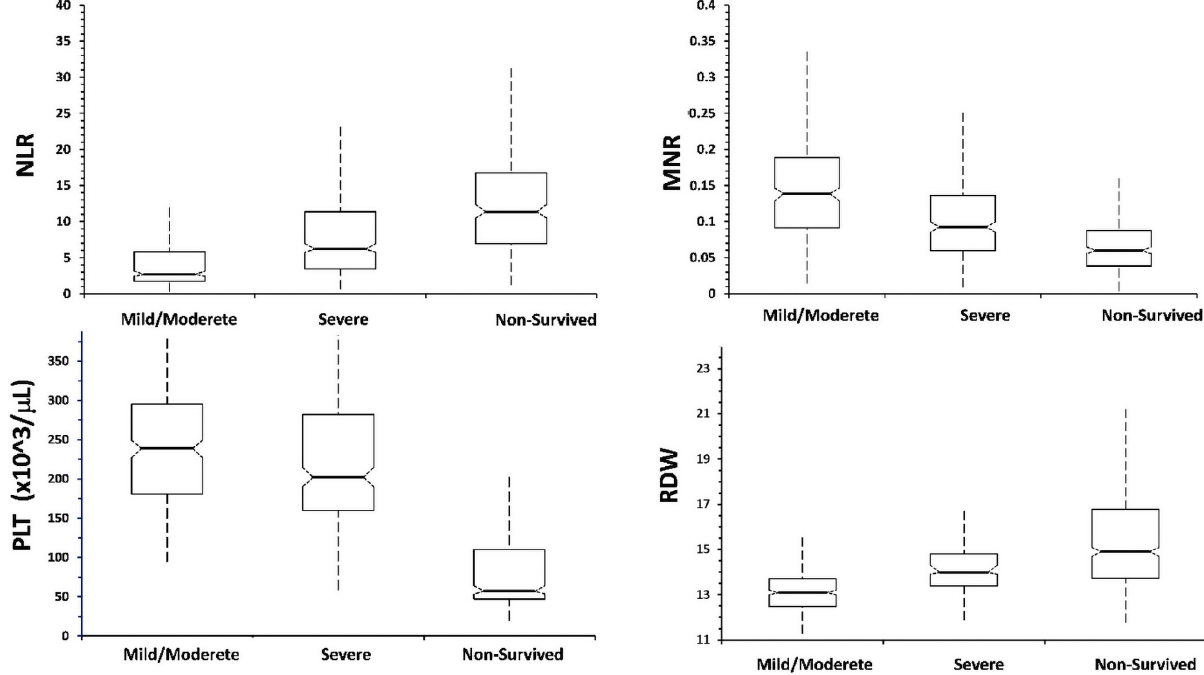
Fig 1. Comparison of hematological parameters with standard deviation between the types of COVID-19